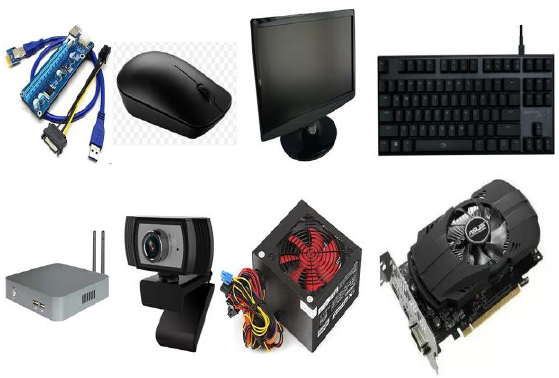
Figure 2.2. Materials Used for Mask Detection